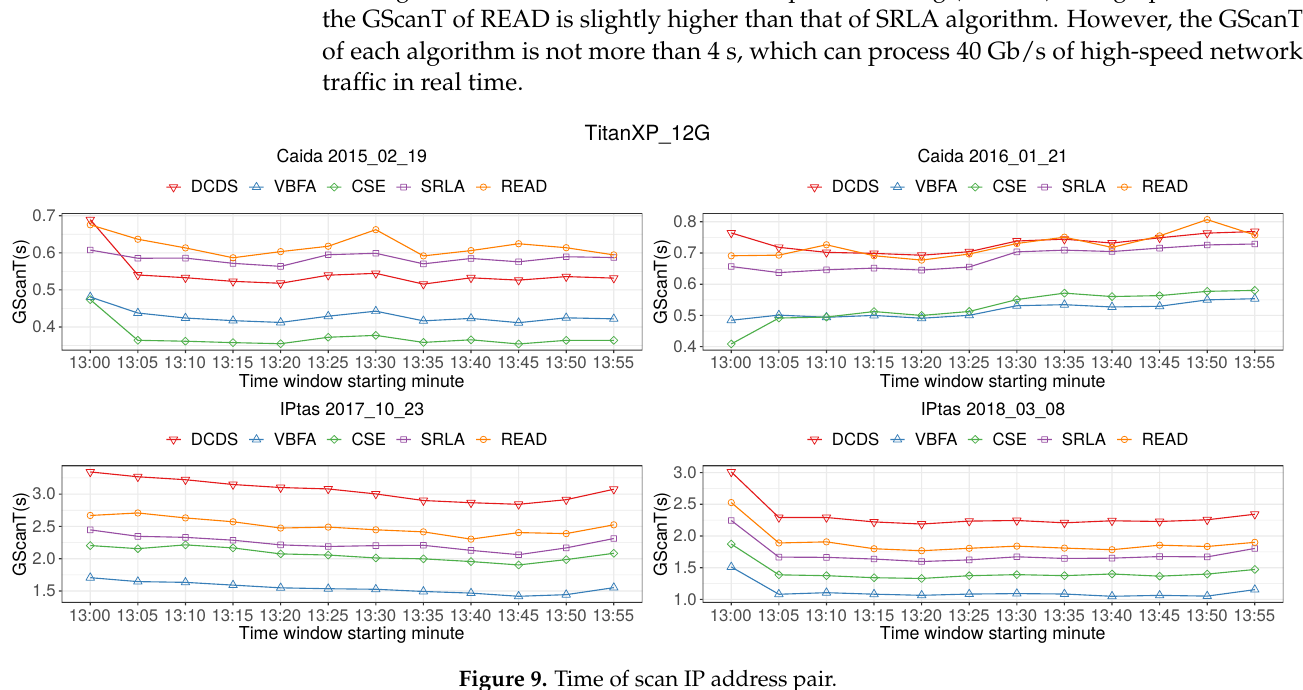
Figure 9. Time of scan IP address pair.